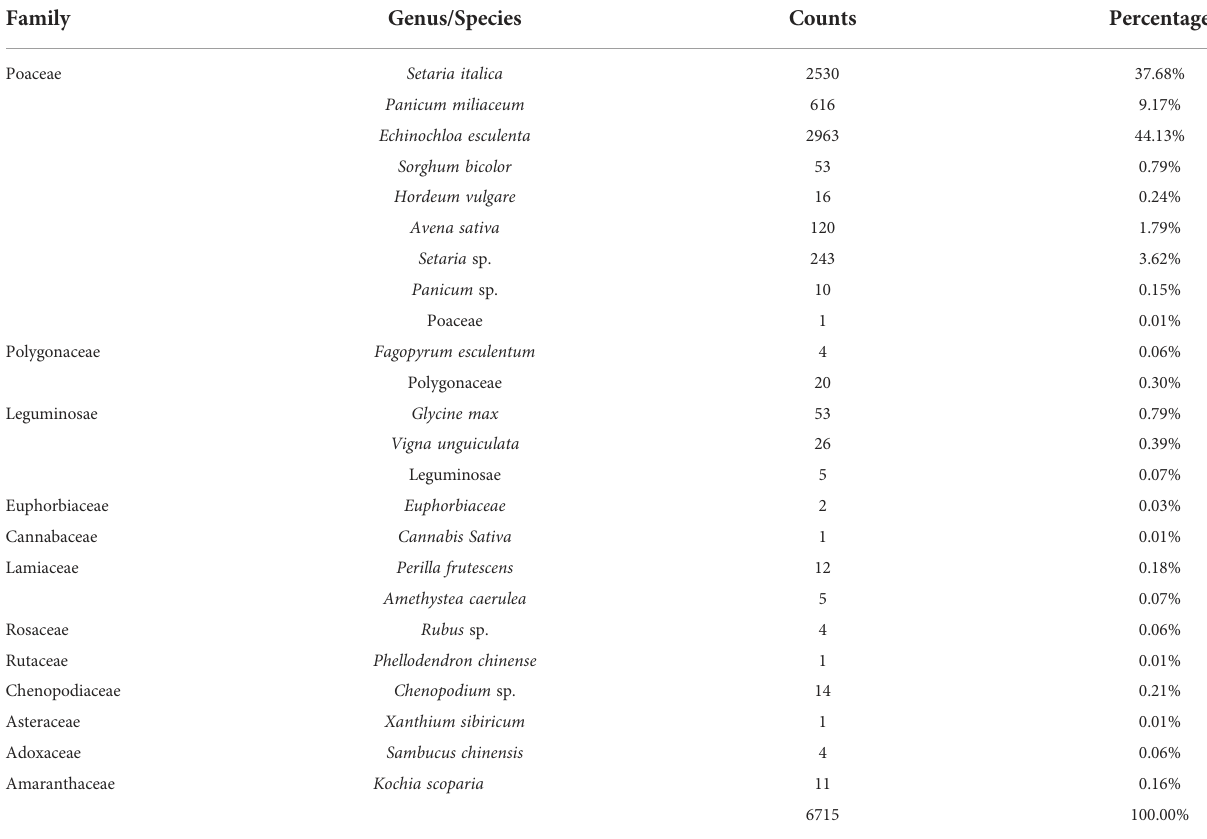
TABLE 2 Statistics of plant seeds unearthed in 2009 at the LMC